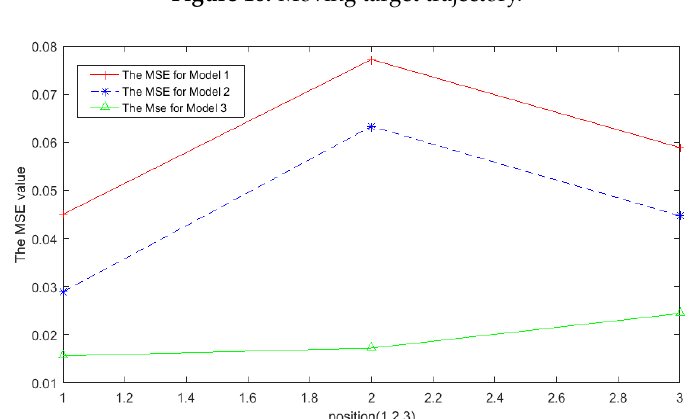
Figure 10. Moving target trajectory.